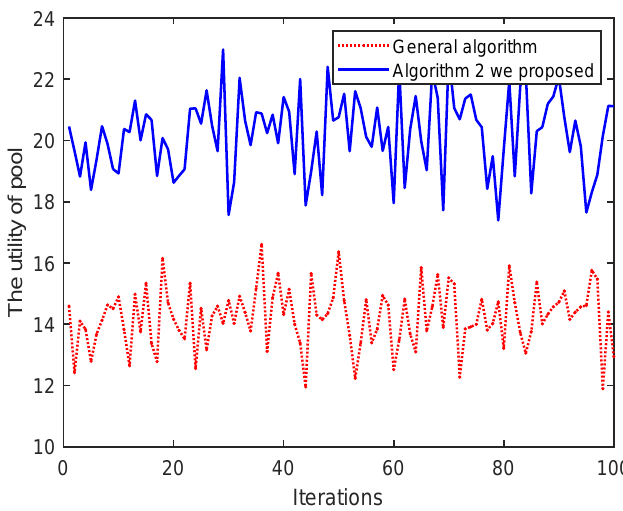
Figure 13. Iterations vs. The utility of miners.